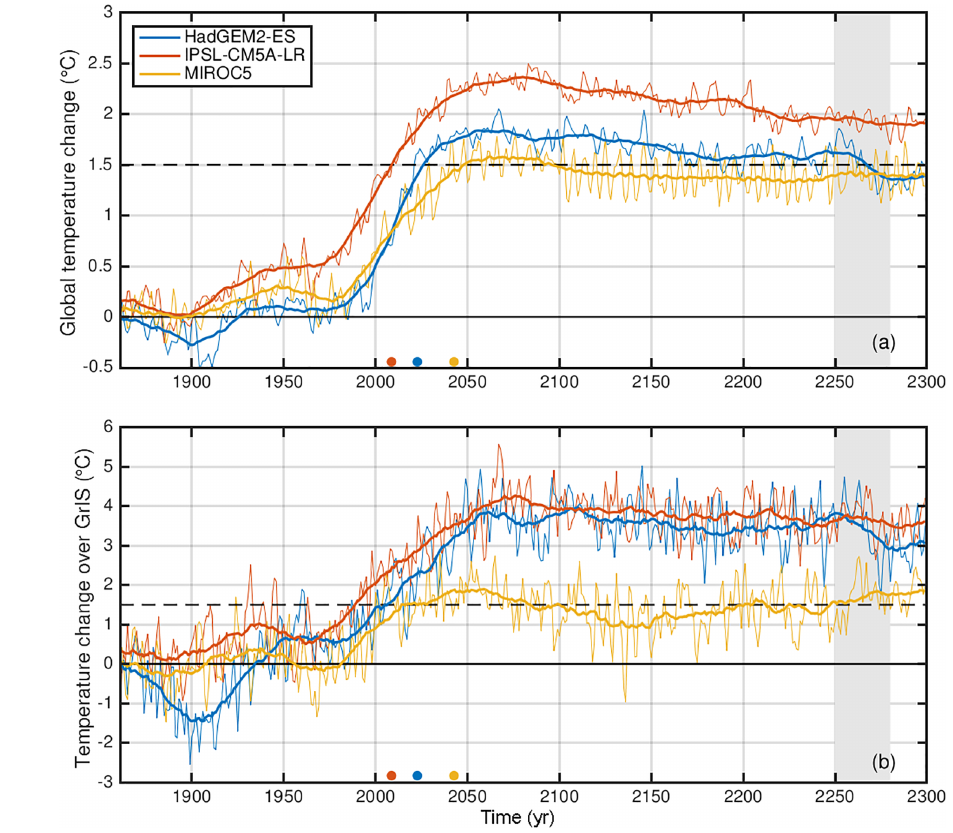
Figure 1. Time series of annual global mean near-surface temperature change (a) and over the GrIS (b) for all three GCMs relative to 1661– 1880. The thick line is a 30-year moving mean. The coloured dots represent the onset years of overshooting 1.5 ◦ C in the global mean near-surface air temperature in a 30-year moving window relative to pre-industrial levels. The light gray shaded area indicates the reused time period for the scenario without